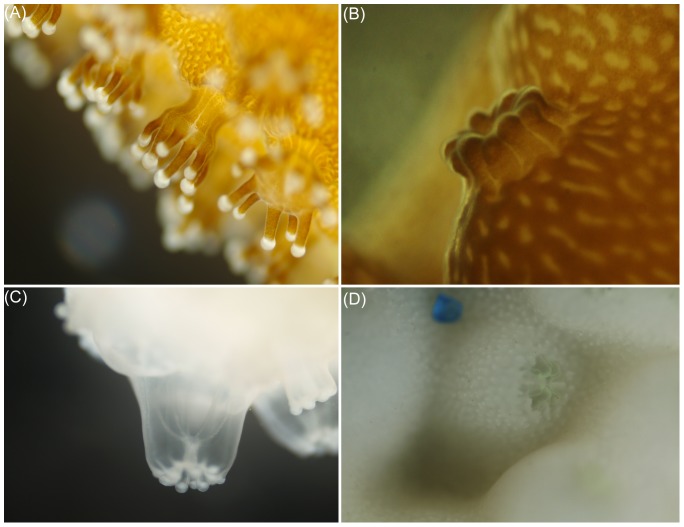
Polyps of symbiotic and aposymbiotic corals under microscopic examination.(A) and (C) are Stylophora pistillata; (B) and (D) are Isopora palifera.